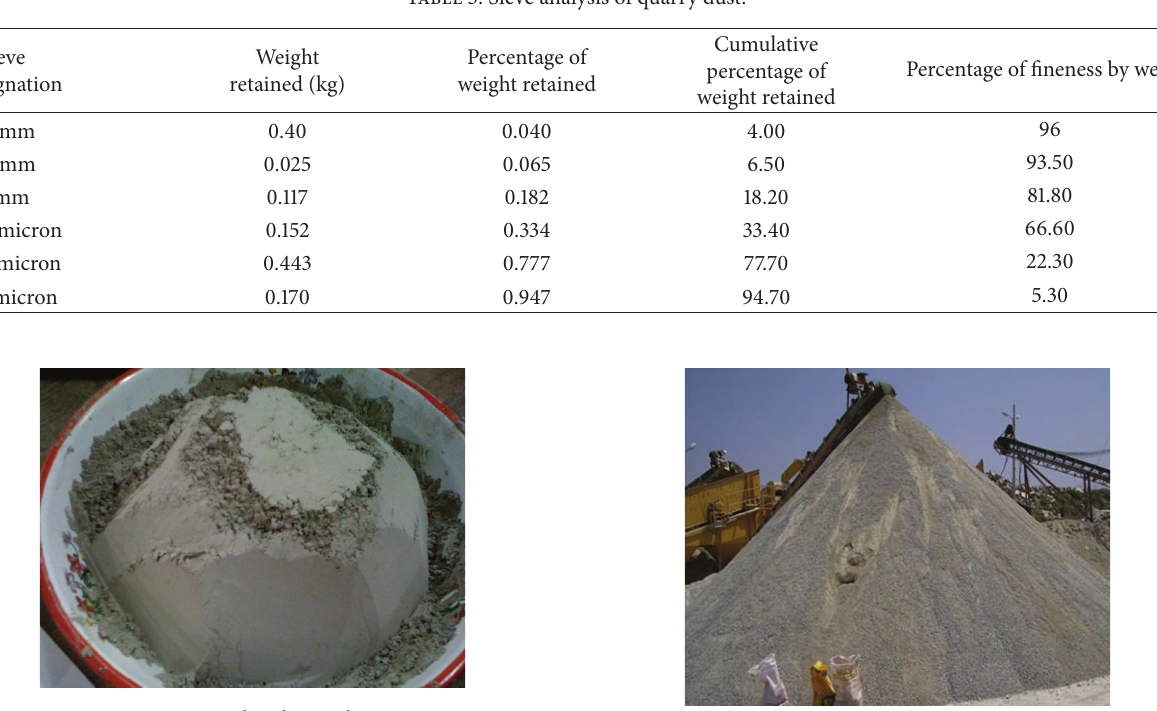
Table 5: Sieve analysis of quarry dust.